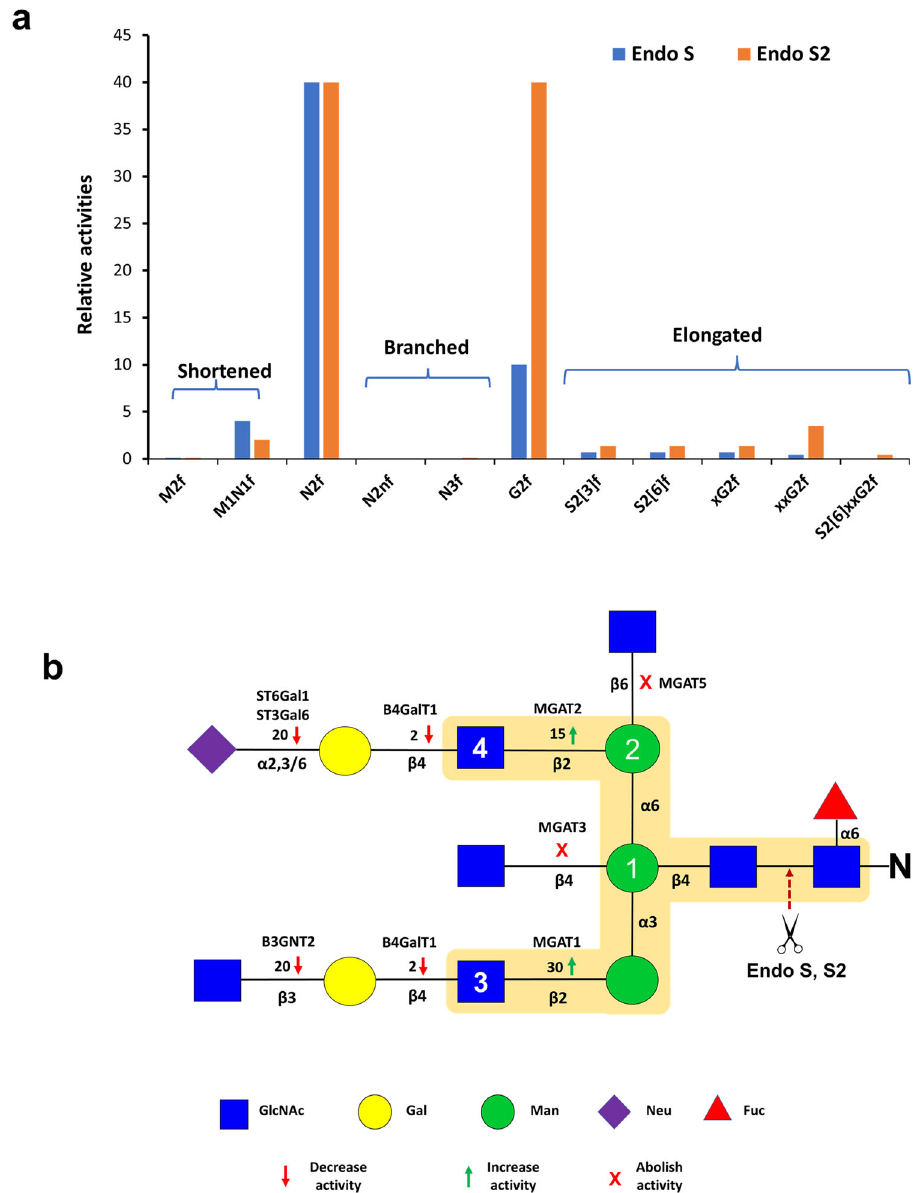
Fig. 6 Relative activities of Endo S/S2 on various substrates and their substrate recognition motifs. a Plot of relative activities of Endo S/S2 on various glycans. Endo S/S2 are most active on N2f and G2f and are much less active on all other glycans. b Endo S/S2 substrate recognition motifs. The impacts of individual monosaccharide modi fi cation introduced by various glycosyltransferases on the activity of Endo S/S2 are indicated with arrows, x symbols and folds of increase/decrease. The key residues identi fi ed from this study are numbered and possible enzyme recognition motif is